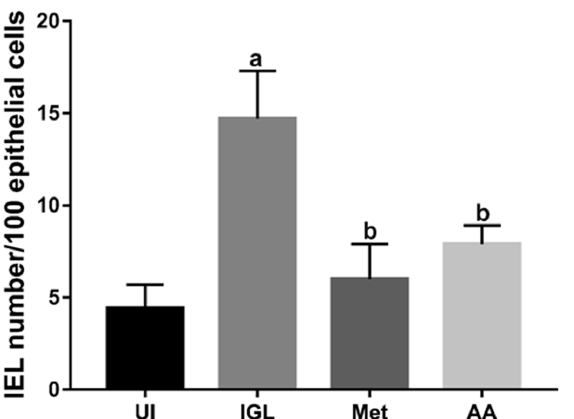
Figure 6. Treatment with A. annua reduced the number of intestinal IELs in infected hamsters. IELs were counted in images of intestinal tissues stained with hematoxylin and eosin. Infection of hamsters with G. lamblia significantly increased IEL count compared to uninfected animals (IGL versus UI). Treatment with A. annua significantly decreased IEL count compared to infected untreated animals (AA versus IGL). No significant difference was found between metronidazole or A. annua treatment (Met versus AA). “ a ” indicates significant difference versus UI group and “ b ” indicates significant difference versus IGL group ( p < 0.001). Data are expressed as means ± SD (n = 3) and were analyzed using ANOVA test with Bonferroni corrections as a post hoc test.